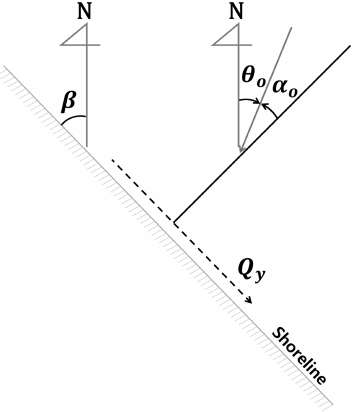
Figure 9. Definition sketch showing deep-water wave angle α O and others for calculating LST rate in this